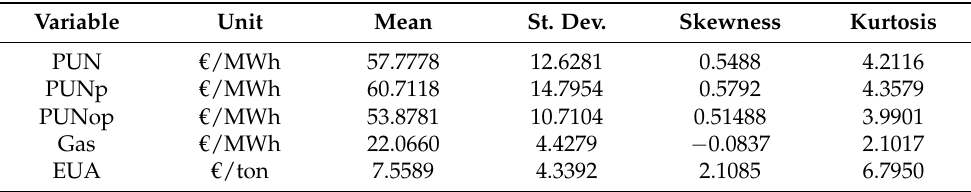
Table A1. Summary